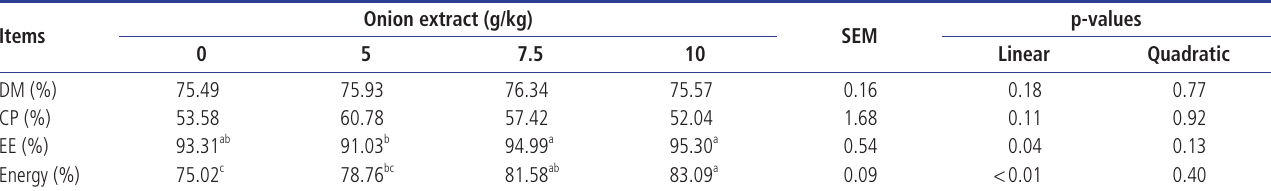
Onion extract (g/kg)